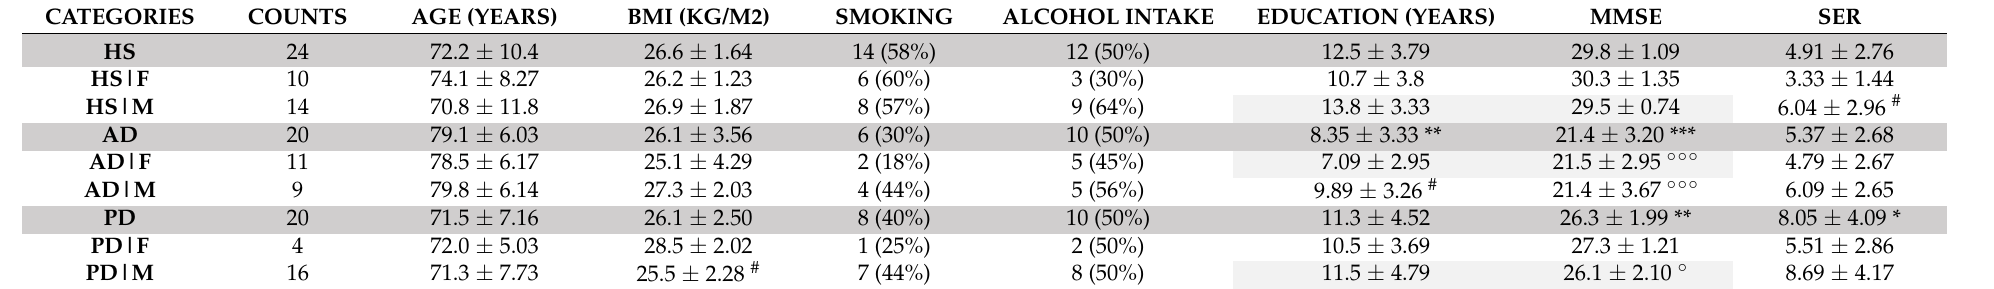
Table 1. Demographics, anthropometrics, lifestyle, education, motor function, and sebum excretion rates, in the three